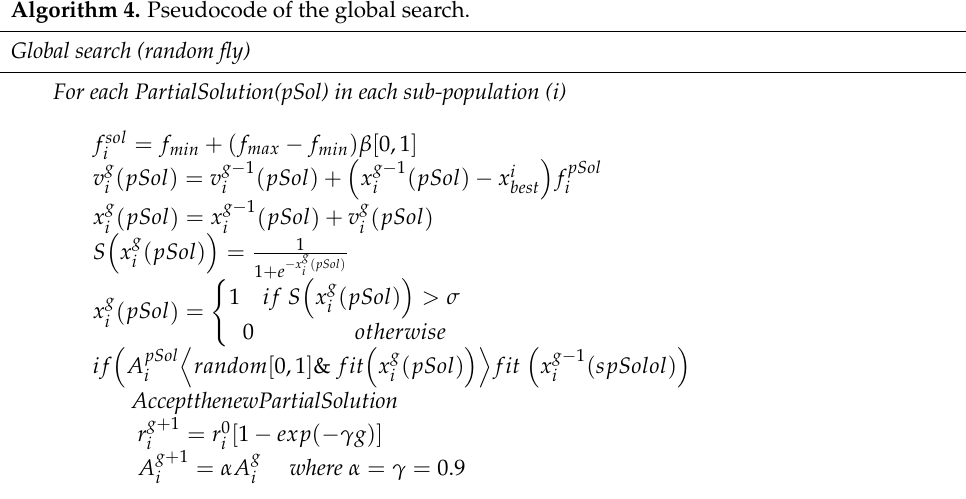
Algorithm 4. Pseudocode of the global search. Global search (random